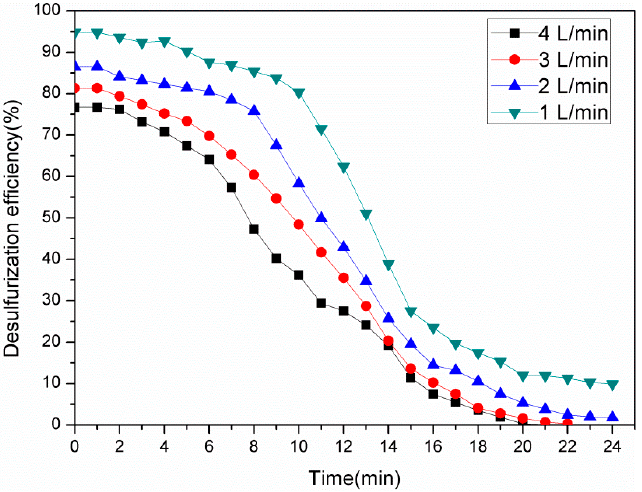
Figure 5. Effect of flue gas flow rate on SO 2 adsorption (operated at 60 °C, 4 g sample, 2000 ppm SO 2 , 5% O 2 , N 2 to balance and 1, 2, 3, 4 L/min total flow rate).